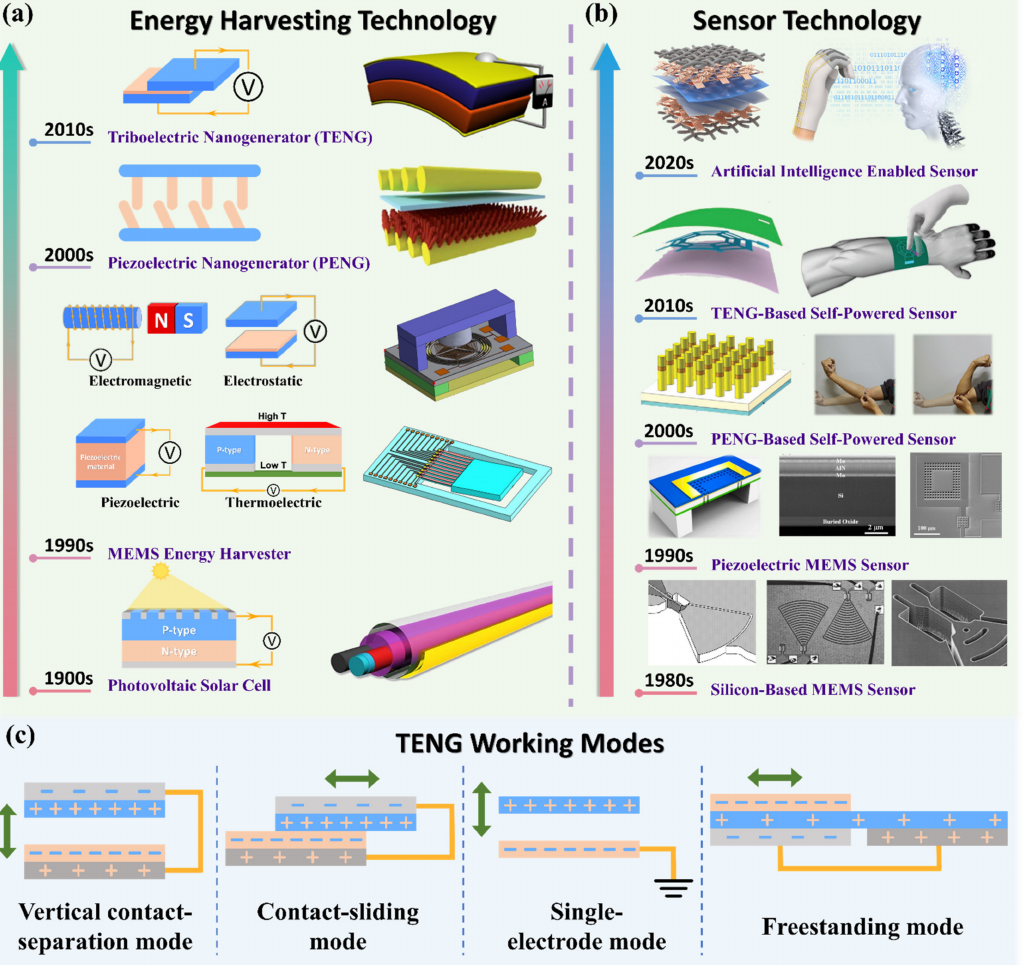
Figure 1. ( a ) Roadmap for the energy harvesting technology and typical works for illustration: